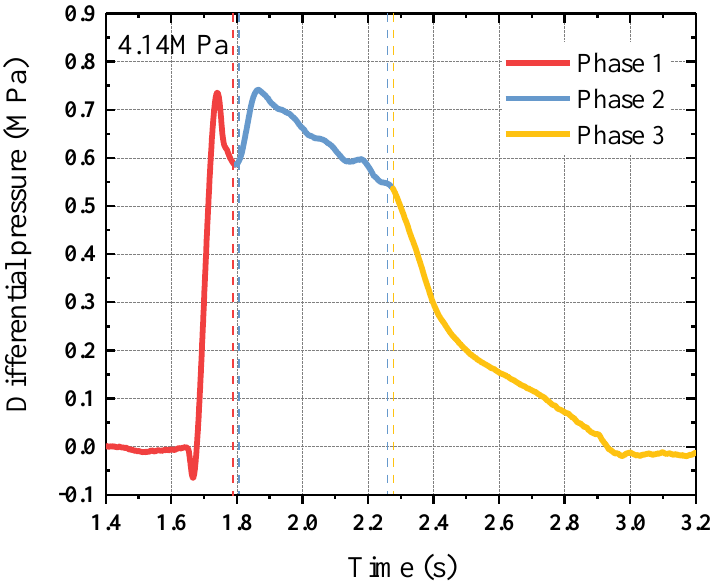
Figure 7. The di ff erential pressure of HFC-125 under di ff erent release pressures.